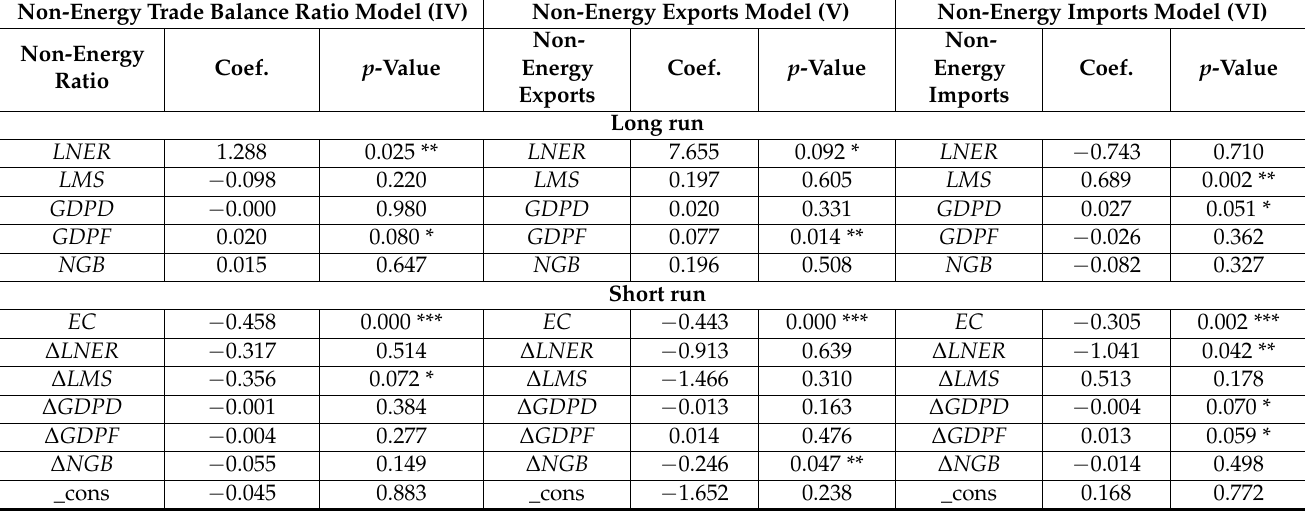
Table A3. The determinants of T&T’s non-energy trade 1991–2019 using DFE.